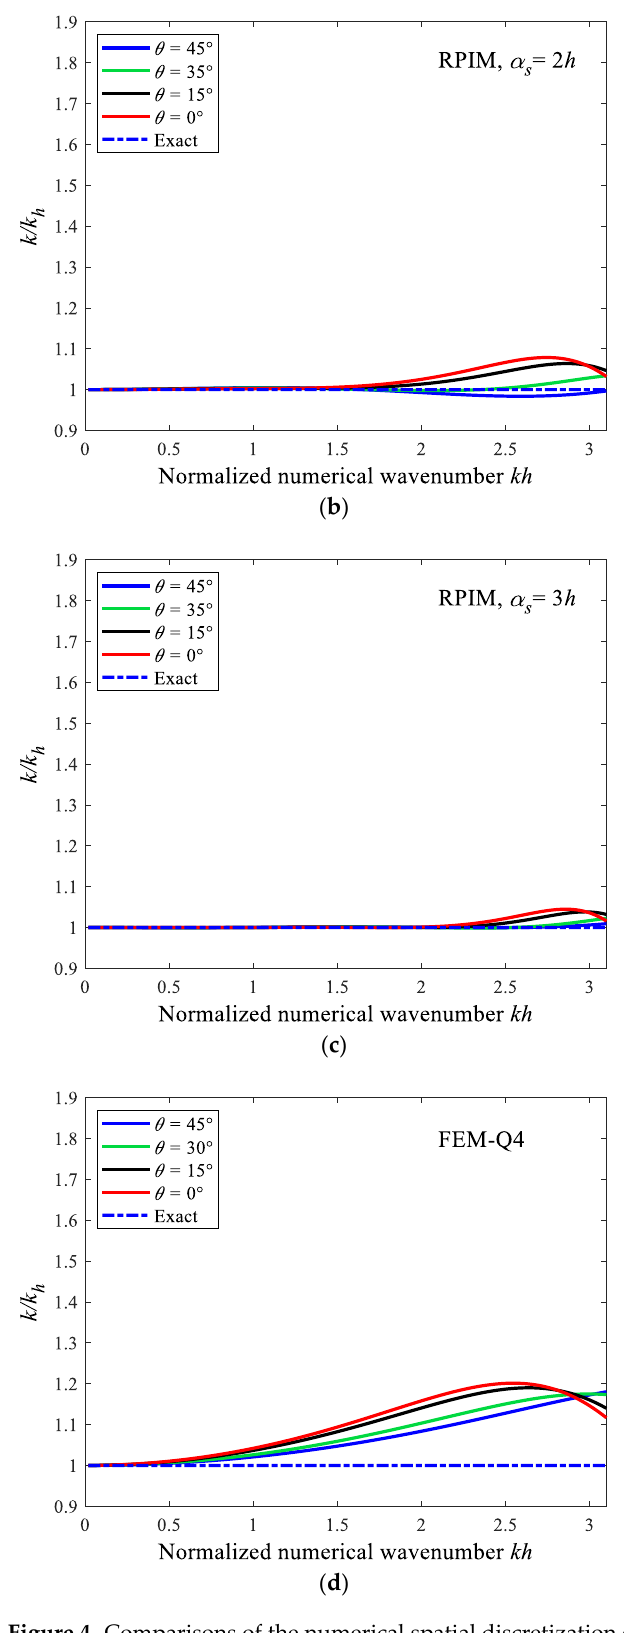
Figure 4. Comparisons of the numerical spatial discretization error results along different angles of wave travel as the functions of the non‑dimensional wave numbers from disparate spatial discretiza‑ tion methods: ( a ) RPIM with α s = h ; ( b ) RPIM with α s = 2 h ; ( c ) RPIM with α s = 3 h ; ( d )